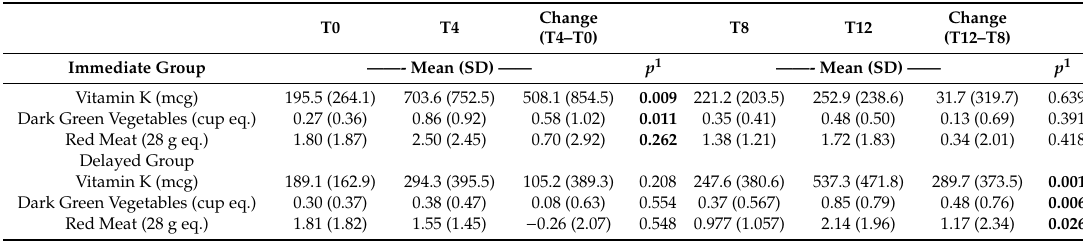
Table 3. Adherence results as measured by 24-h dietary recall data generated from the Automated Self-Administered 24-Hour Dietary Assessment tool (ASA24) in a randomized controlled crossover high green leafy vegetable dietary intervention. T0